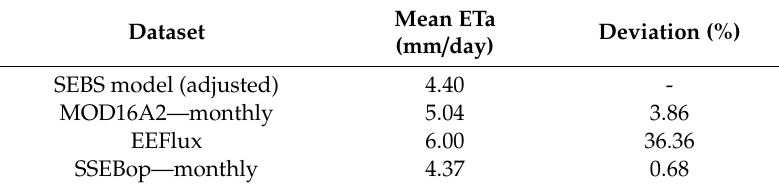
Table 3. Mean daily ETa values estimated with the three products compared to the adjusted value by the SEBS model in August